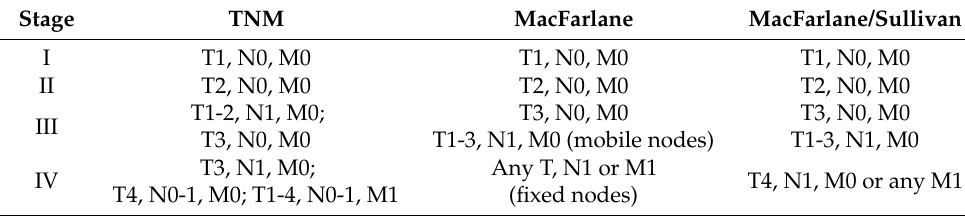
Table 5. Difference among the staging systems TNM, MacFarlane and MacFarlane/Sullivan.